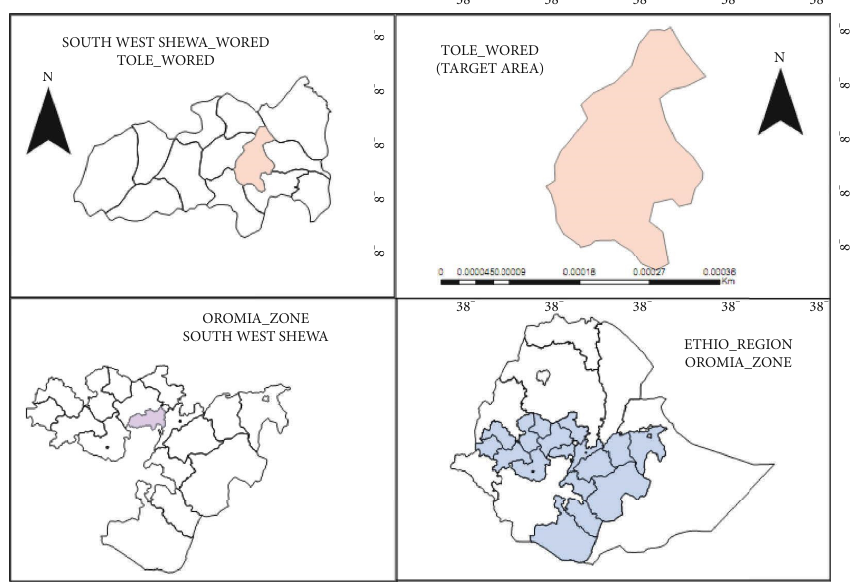
Figure 1: Map showing the study